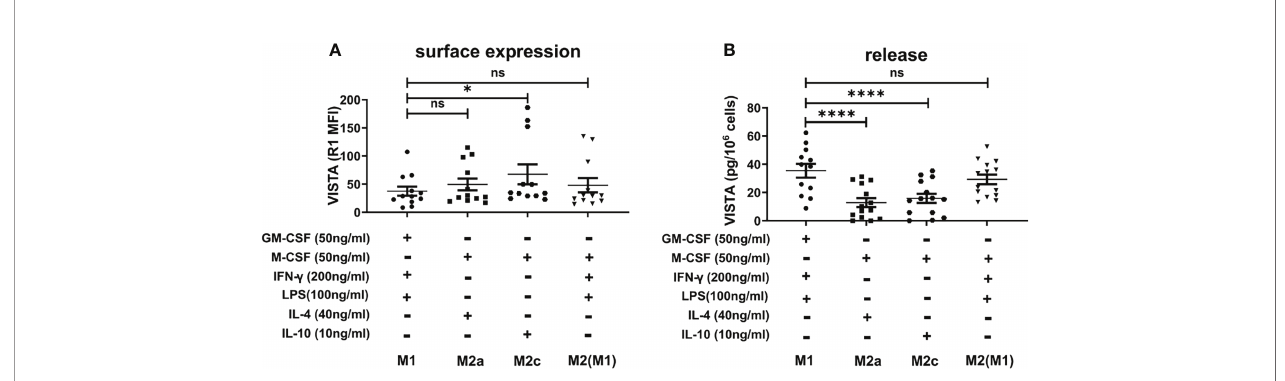
FIGURE 4 | VISTA production in activated M1 and M2 macrophage subtypes (A) VISTA surface expression was determined by fl ow cytometry. (B) Soluble VISTA release was determined by a sandwich ELISA. Data are the mean values ± SEM (n=12-14). *p < 0.05, ****p < 0.0001, ns, non-signi fi cant (p>0.05)